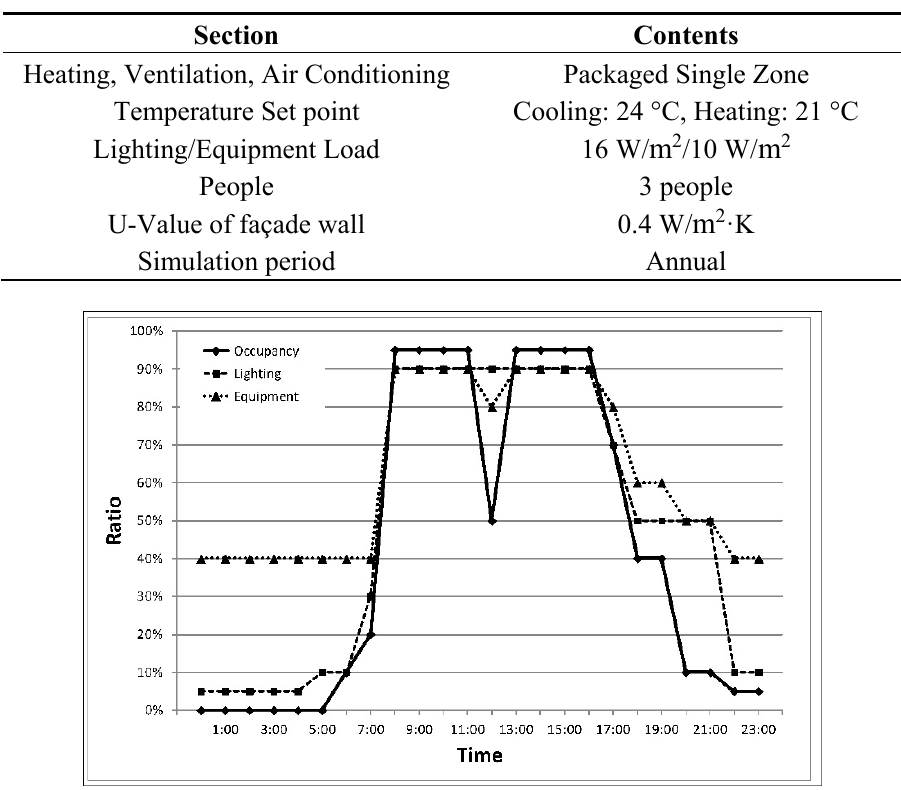
Figure 3. Simulation